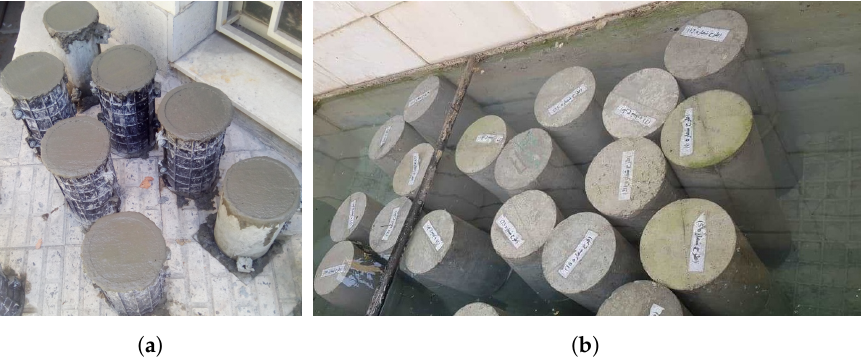
Figure 3. ( a ) Molding the concrete specimens and, ( b ) Curing the cylindrical specimens. Table 2. Physical and chemical specification of the Portland cement.